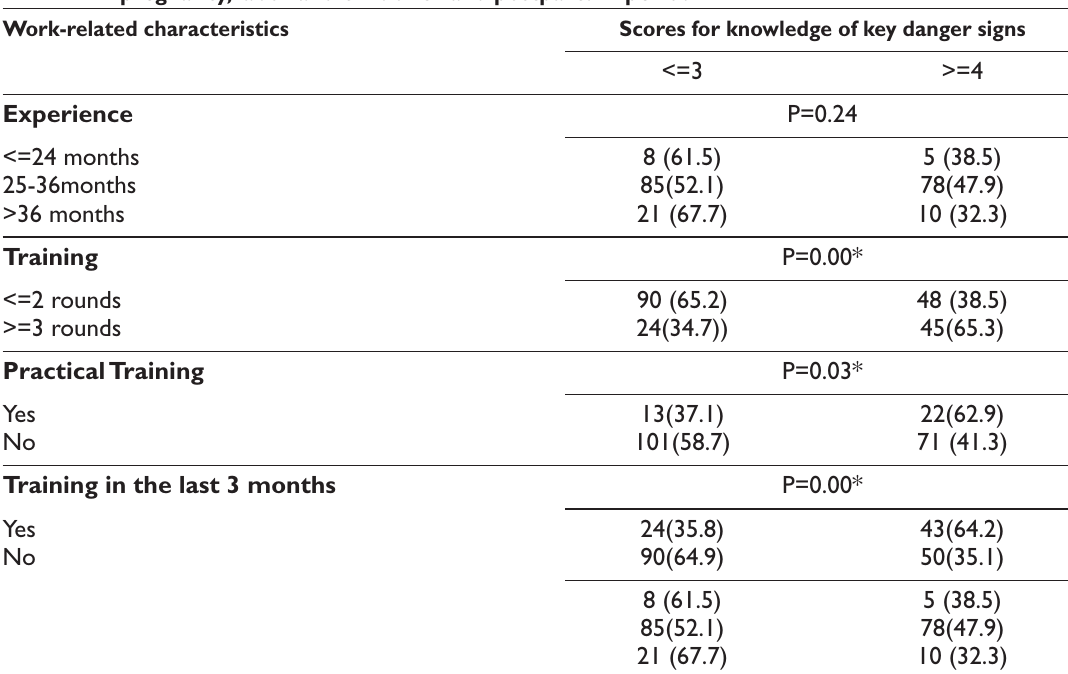
Work-related characteristics of ASHAs and their knowledge of key danger signs of pregnancy, labor and childbirth and postpartum period Work-related characteristics Scores for knowledge of key danger